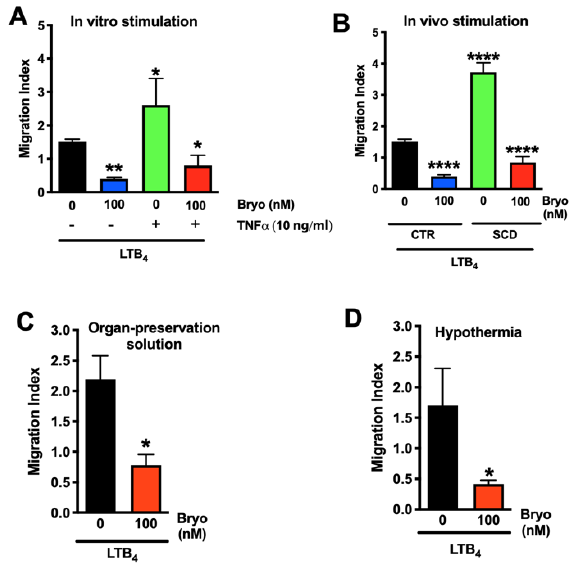
Figure 4. Bryostatin-1 reduces neutrophil transmigration under clinically relevant conditions. ( A , B ) Bryostatin-1 (Bryo, 100 nM) blocked hypoxia-elicited transmigration of stimulated neutrophils across confluent human umbilical vein endothelial cell (HUVEC) monolayers toward leukotriene B4 (LTB 4 , 10 −6 M). ( A ) Neutrophils were stimulated in vitro by a 30-min treatment with tumor necrosis factor alpha (TNF- α ). ( B ) Neutrophils were obtained from patients with sickle cell disease (SCD) and compared to neutrophils from control (CTR, healthy donors). ( C , D ) Bryostatin-1 (100 nM) remained effective in blocking hypoxia-elicited neutrophil transmigration across confluent HUVECs monolayers towards LTB 4 even when ( C ) Bryostatin-1 was suspended in organ preservation solution (University of Wisconsin solution) or when ( D ) experiments were conducted under hypothermic conditions (4°). The migration index was calculated by dividing the number of calcein-AM labeled neutrophils that migrated to LTB 4 by the number of cells that migrated to the vehicle. All results are representative of at least three independent experiments (n = 3 – 7). Graphs present mean ± SEM. Data were analyzed with ANOVA with Bonferroni post-tests ( A , B ) or Student’s t -test ( C , D ). Significance is indicated by the following symbols: * p < 0.05 versus vehicle control, ** p < 0.01 versus vehicle control, **** p < 0.0001 versus vehicle control.